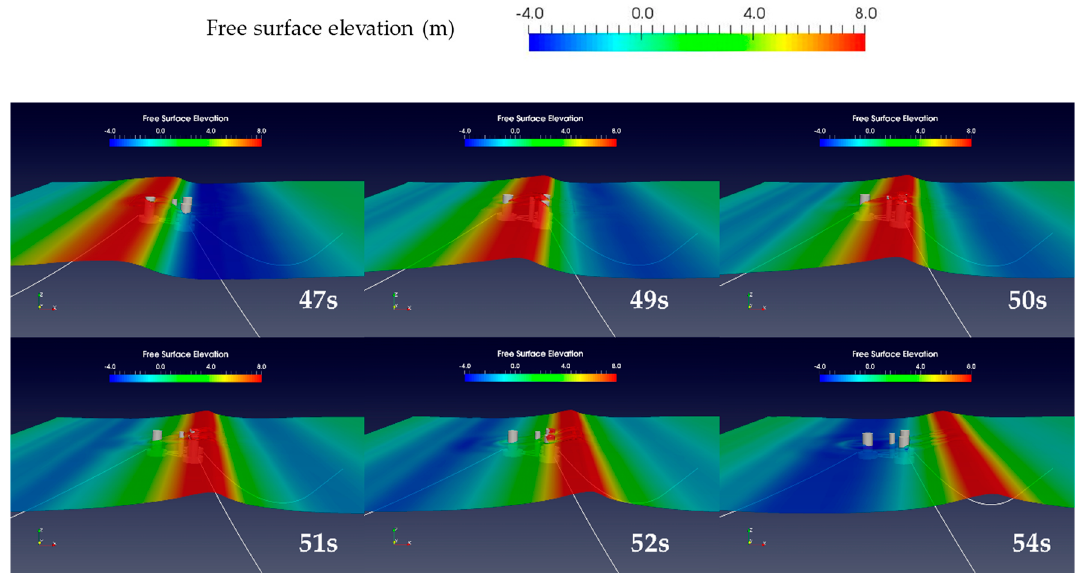
Figure 19. Maximum and minimum value of 3 DOF motion under di ff erent focused waves.